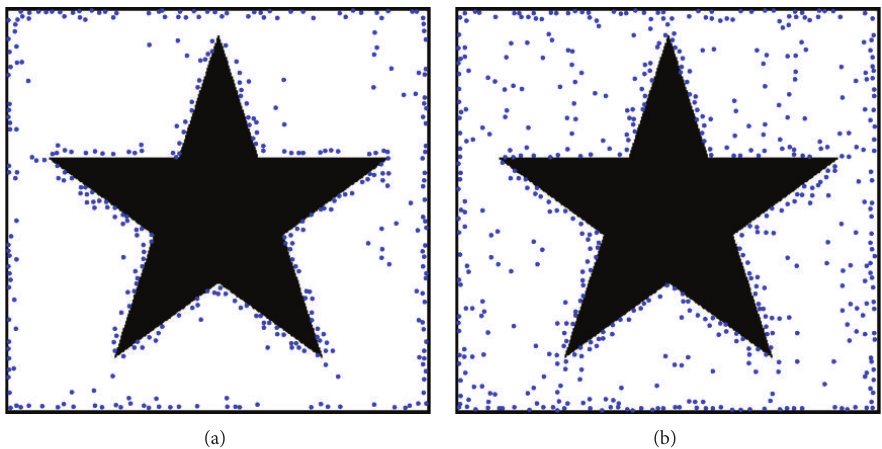
Figure 10: Boundary recognition in sparse WSN. (a) 10.9 in average degree and (b) 8.9 in average degree.